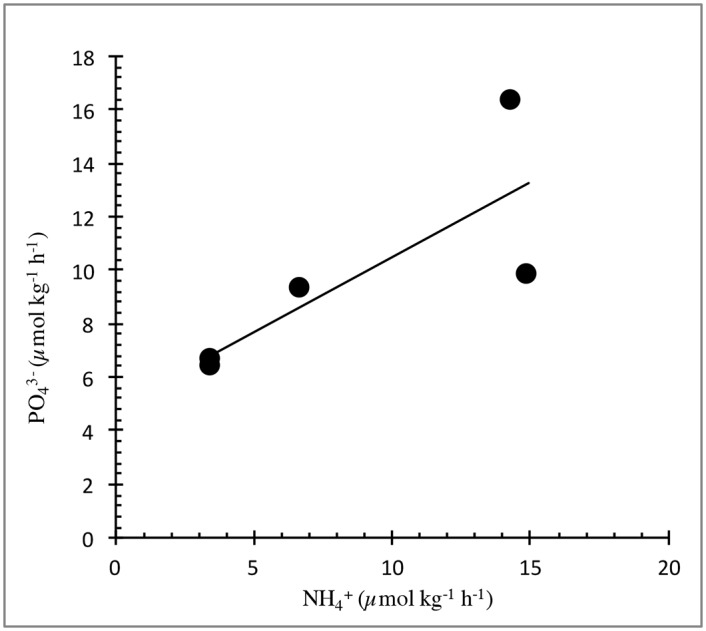
Regression analysis of release rates for NH4+ and PO43- for right whale feces.Rates were calculated for the period between the initial sampling and the first time point during the fecal suspension incubation experiments, R2 = 0.63.